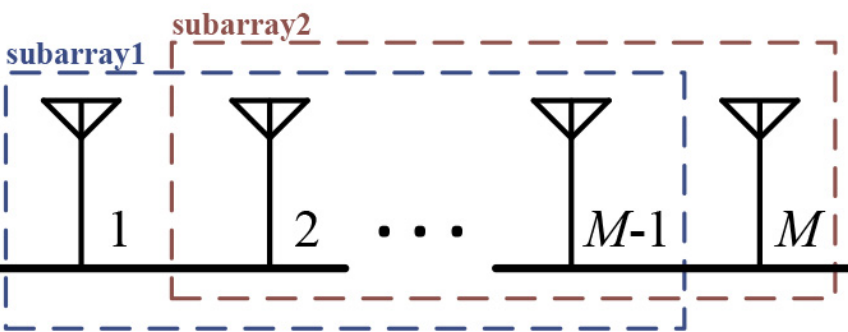
Figure 2. Subarray structure for estimation of signal parameters via rotational invariance techniques (ESPRIT)